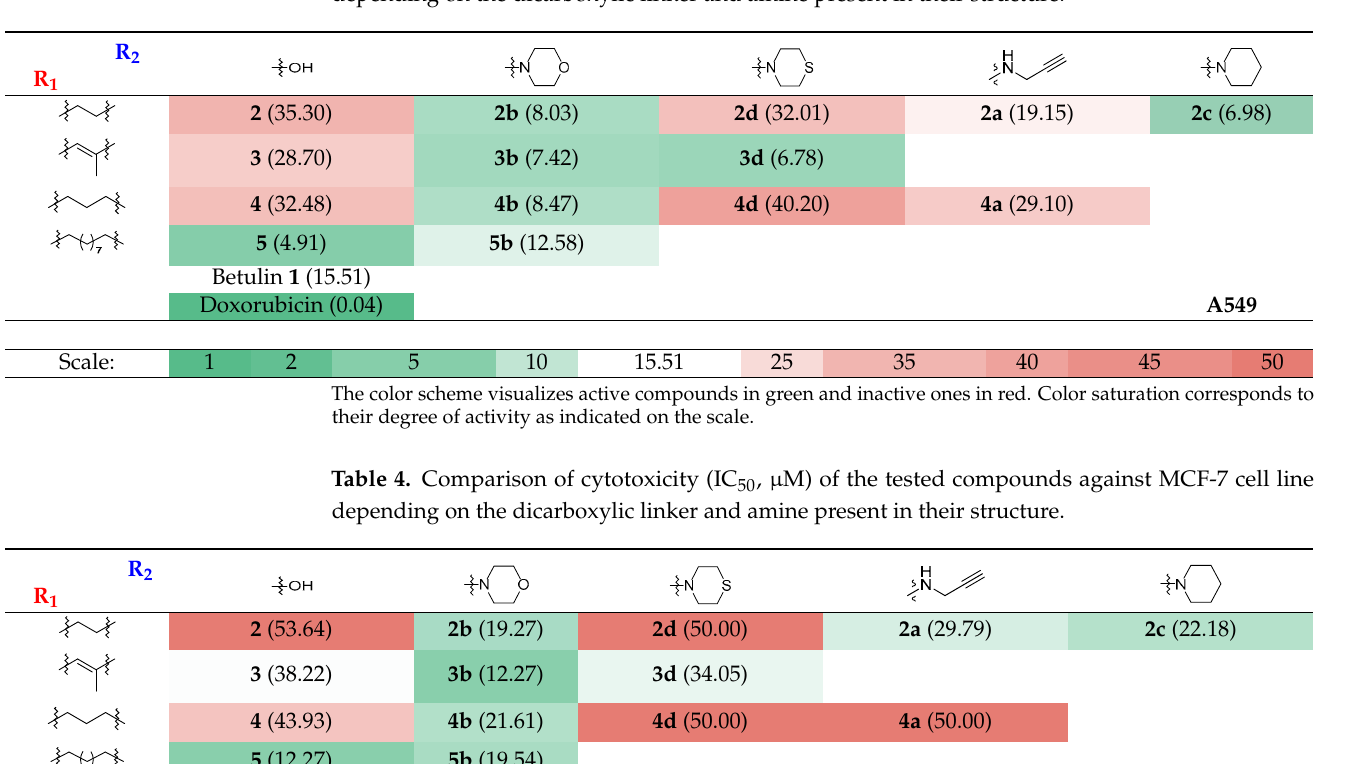
Table 3. Comparison of cytotoxicity (IC 50 , µM) of the tested compounds against A549cell line depending on the dicarboxylic linker and amine present in their structure.